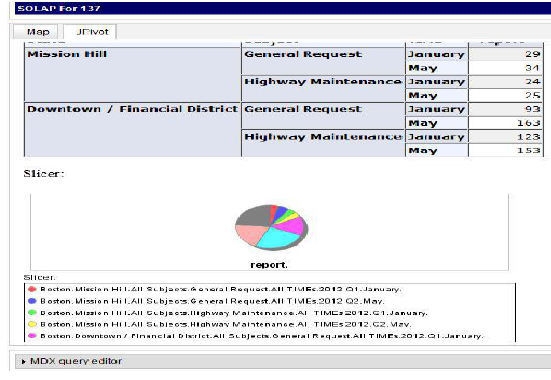
Figure 8. JPivot tab of the developed